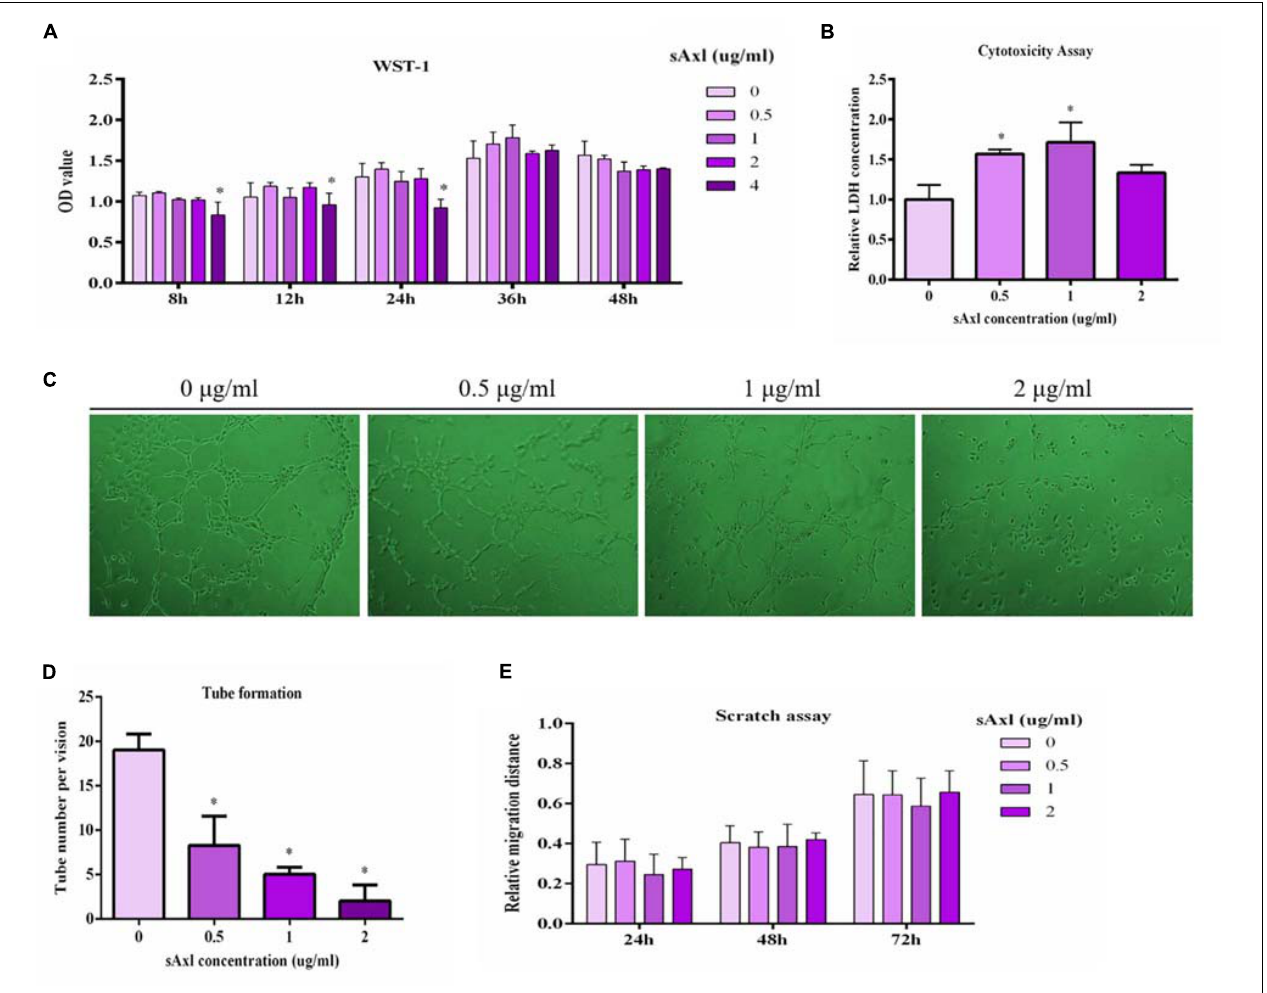
FIGURE 3 | Effects of sAxl on endothelial proliferative, cytotoxicity, tube formation, and migration. (A) Cell proliferation was detected by WST-1. (B) Cytotoxicity assay was evaluated by the LDH release assay. (C,D) The tube formation of vascular endothelial cells after 8 h of sAxl culture at different levels was observed. (E) Migration ability was detected by scratch assay. The results are presented as mean ± SD. * p < 0.05, ** p < 0.01 vs. respective controls. n = 3 per